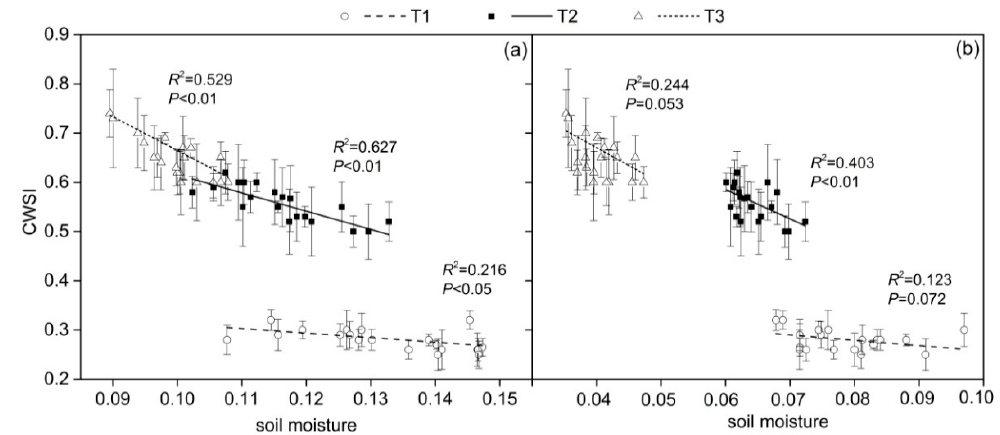
Figure 8. The relationship between the CWSI and the soil moisture of different layers under different treatments. ( a ) represents the relationship between soil moisture content of 0–40 cm and CWSI; ( b ) represents the relationship between soil moisture content of 0–80 cm and CWSI. T 1 represents 100% M, T 2 represents 80% M, T 3 represents 60%.